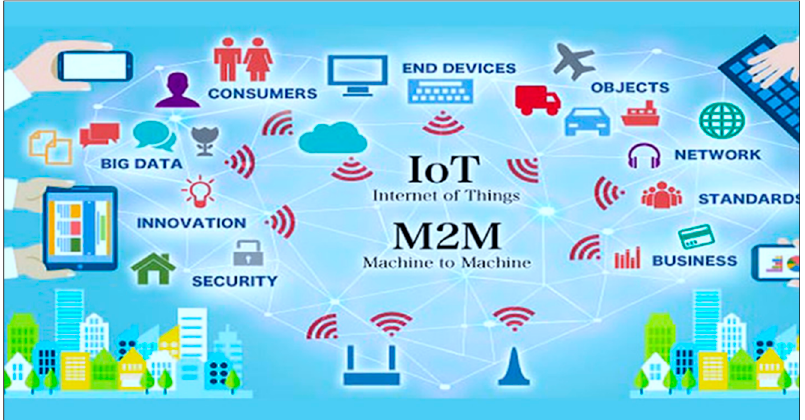
Figure 1. Machine-to-machine (m2m) and machine-to-human (m2h) communication in IoT (https://www.peerbits.com/blog/difference-between-m2m-and-iot.html). Intruder intervention can be limited by registering devices to the network [15]. Anomaly